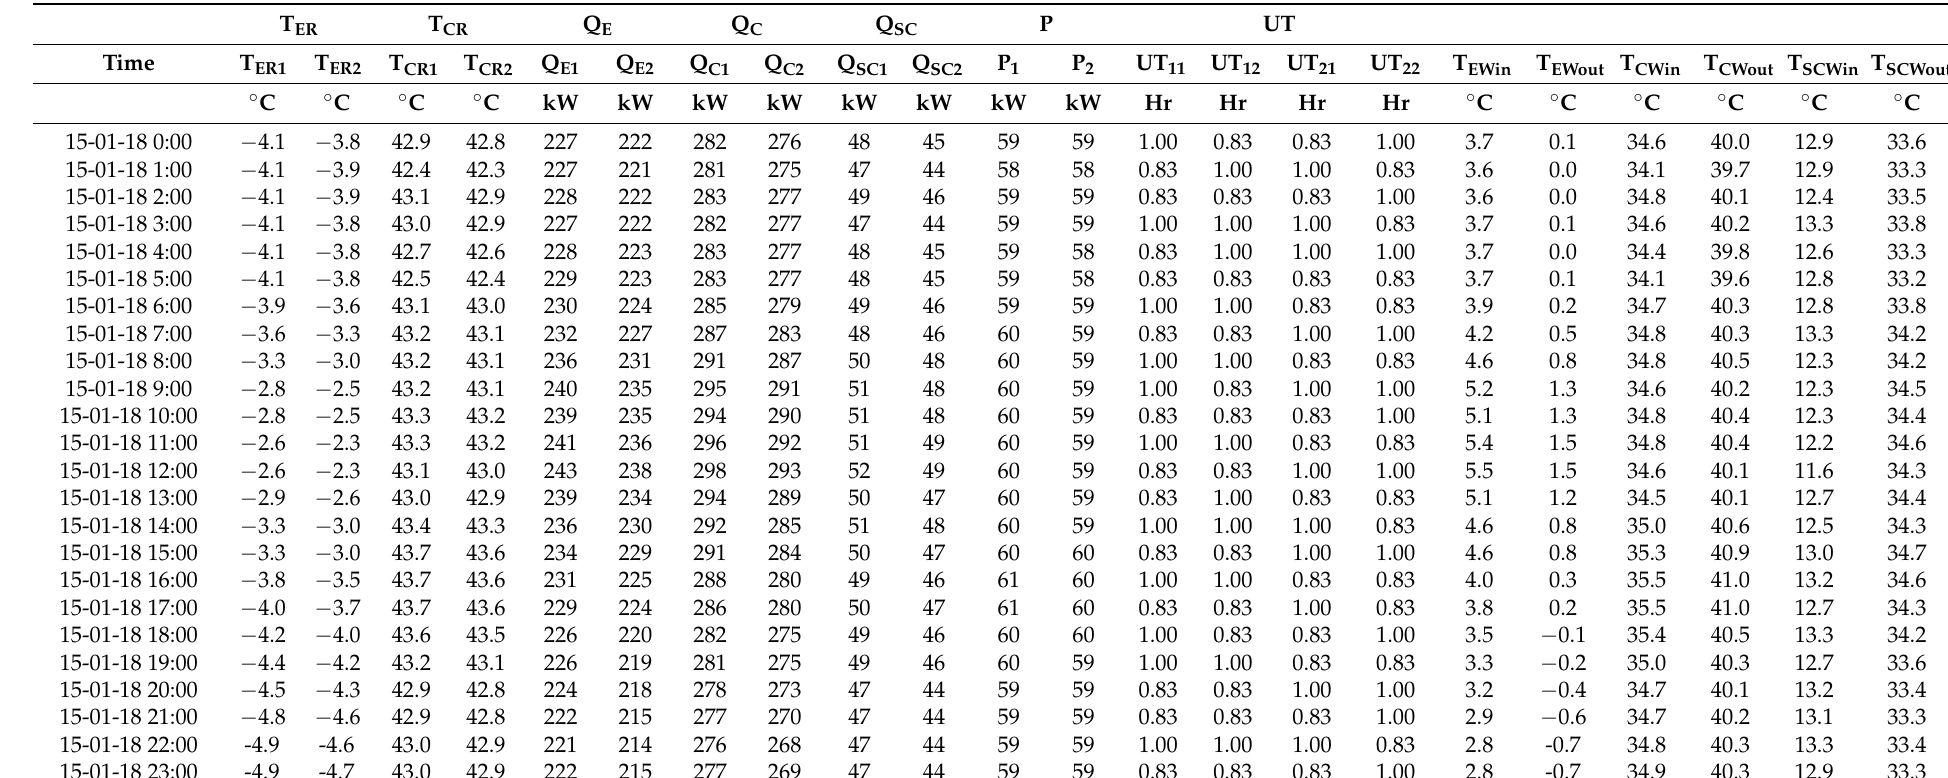
Table A1. Sample data from HP1 for a typical winter